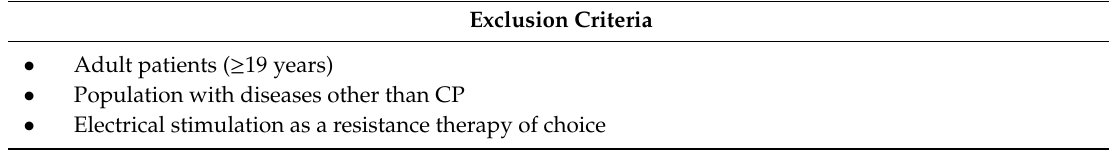
Figure 1. Flowchart used for the identification of clinical trials and studies with intervention based on resistance therapy and motor function measured as the outcome variable.